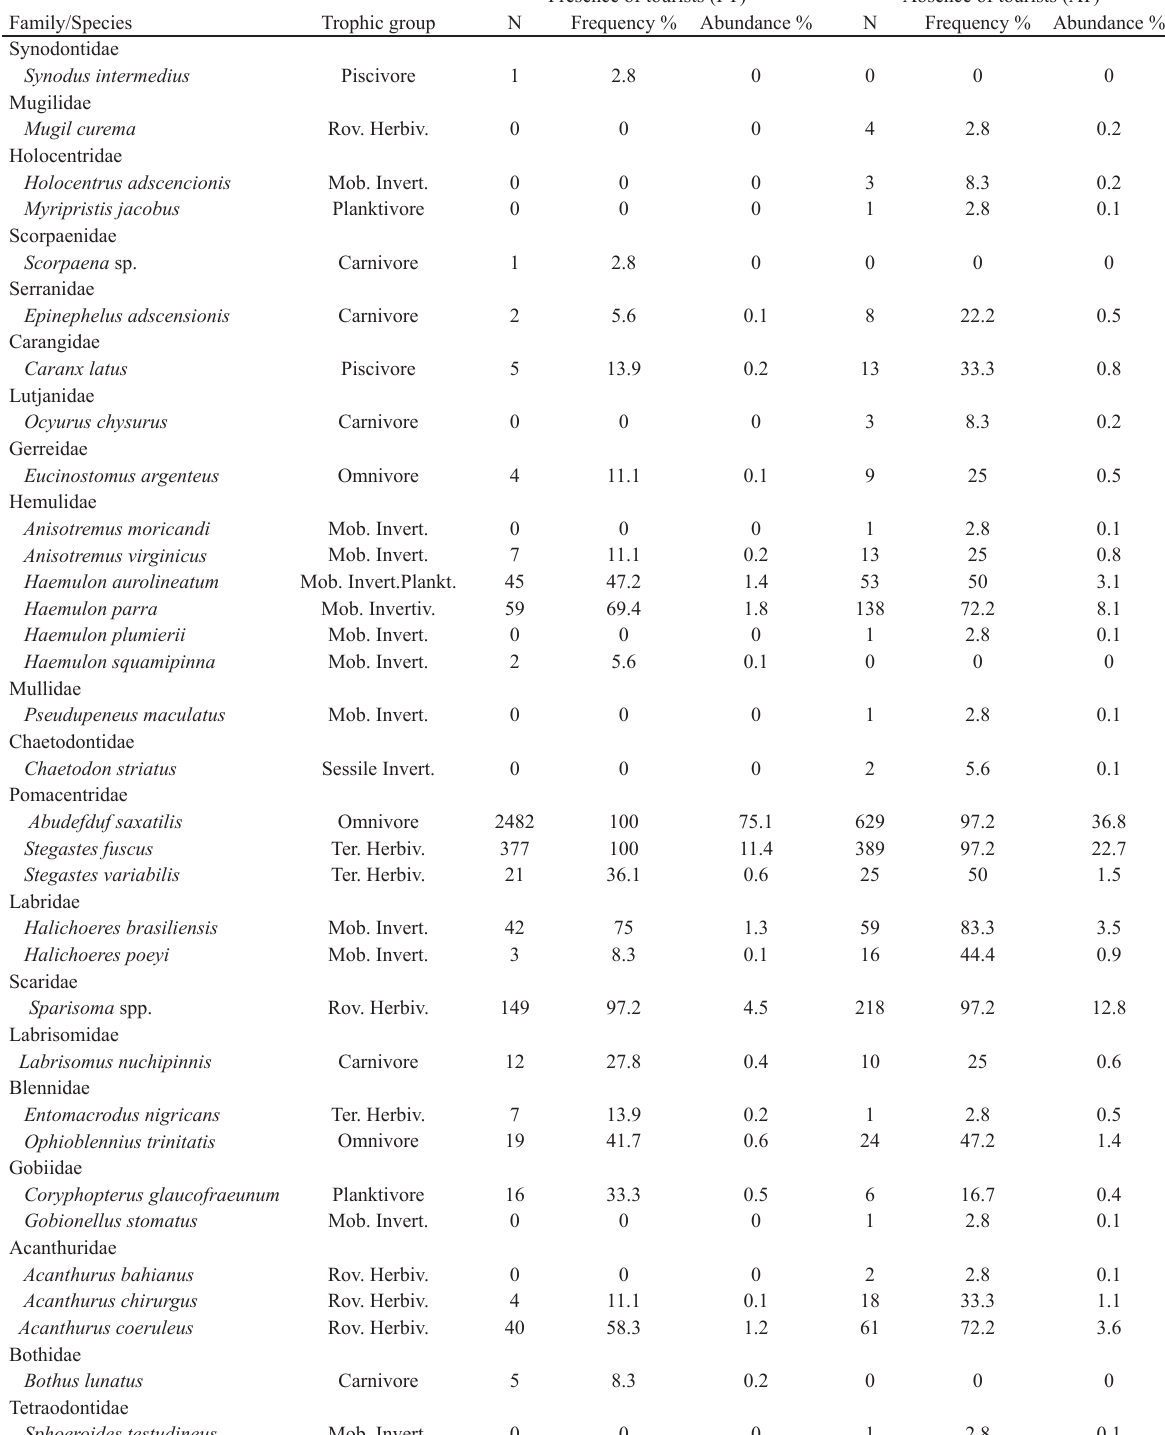
Table 1. Trophic categories, number of individuals (N), frequency and relative abundance (% of total number of individu- als) of reef fishes in the two periods, at presence of tourists (PT) and at absence of tourists (AT). The families are listed in phylogenetic order, following Nelson (2006); species are alphabetically organized within each family. Rov. Herbiv. = Roving herbivore; Mob. Invert. = Mobile Invertivore; Plankt. = Planktivore; Ter. Herbiv. = Territorial